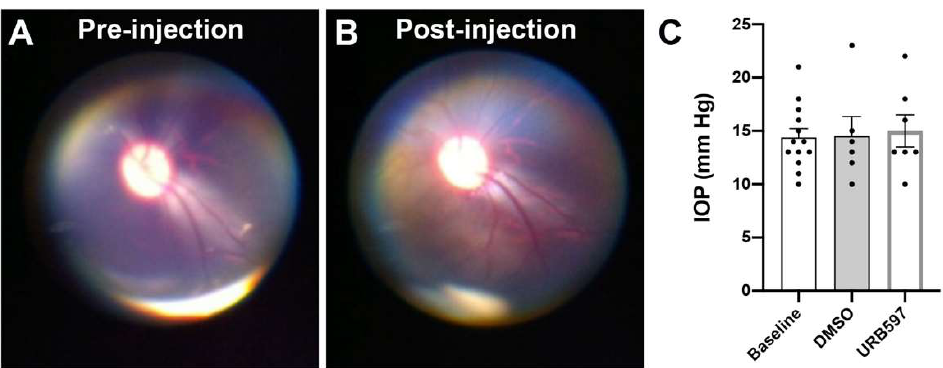
Figure 1. Fundus observation and assessment of intraocular pressure (IOP) with individual values. No differences in the fundus of the eyes before ( A ) or after a typical intravitreal injection ( B ). IOP values did not differ at baseline (before intravitreal injections), post-DMSO injection or post-URB597 injections ( C ). Error bars represent standard error of the means (SEM).